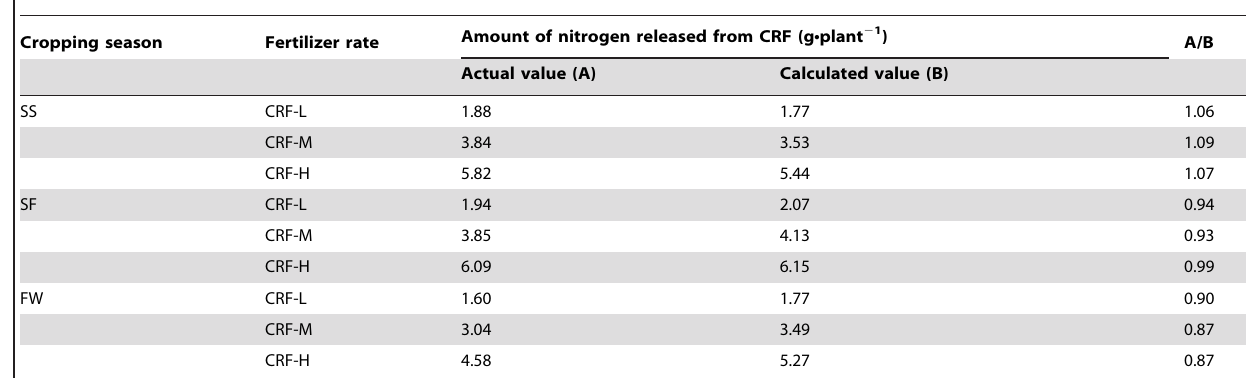
Table 2. Amount of nitrogen released from CRF in each cropping